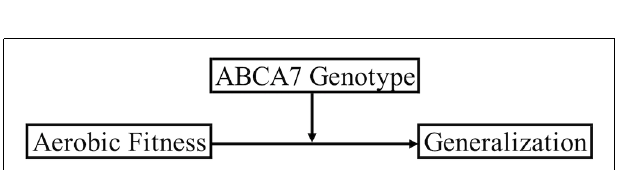
FIGURE 5 | ABCA7 genotype significantly moderates the relationship between aerobic fitness and generalization.